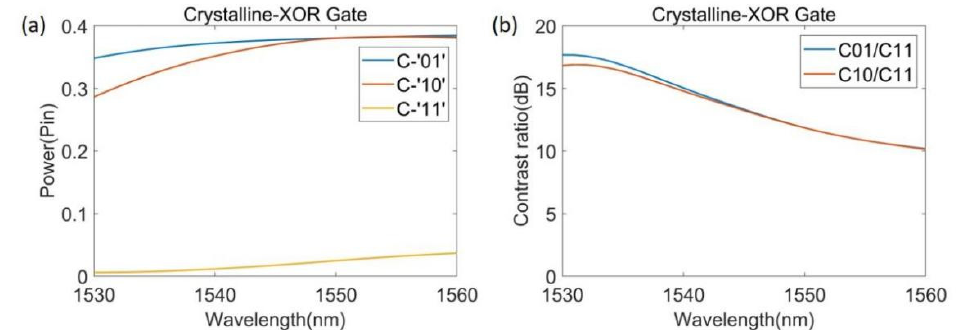
Figure 4. Performance graph of XOR gate. ( a ) Spectral power curve of the XOR gate when Sb 2 Se 3 was in the crystalline state; ( b ) Contrast ratio curve of the XOR gate.